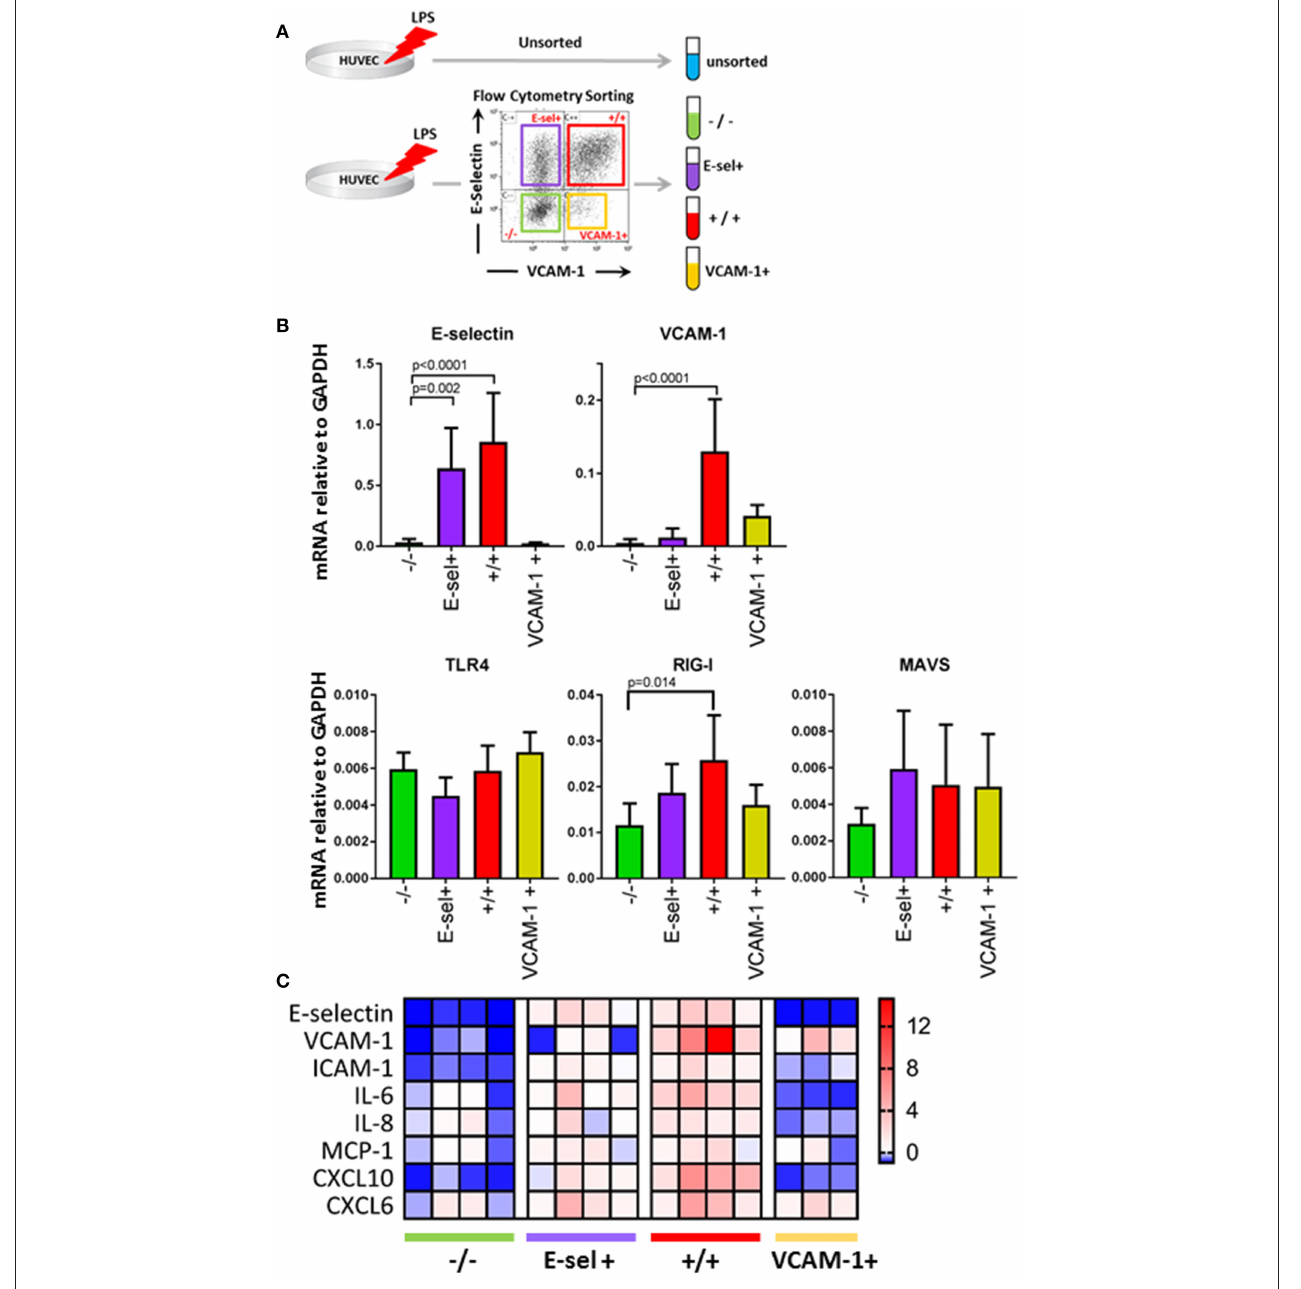
FIGURE 4 | Endothelial subpopulations have distinct mRNA expression levels of LPS signaling pathway components and inflammatory genes. (A) Experimental design for EC sorting using FACS. (B) mRNA expression levels of E-selectin, VCAM-1, TLR4, RIG-I, and MAVS in sorted EC subpopulations as determined by RT-qPCR using GAPDH as the housekeeping gene. Bars represent the mean ± SD of 5 independent experiments. p < 0.05 is considered statistically significant. (C) Heatmap displaying pro-inflammatory adhesion molecule, cytokine, and chemokine mRNA levels in sorted EC subpopulations compared to unsorted LPS control EC. The data shown is from four independent